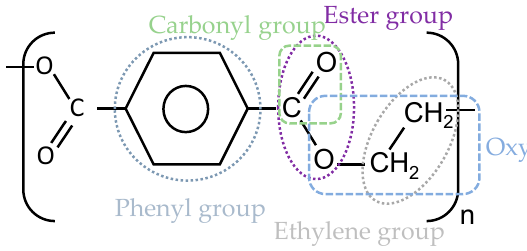
Figure 3. The repeating unit of PET (C 10 H 8 O 4 ).